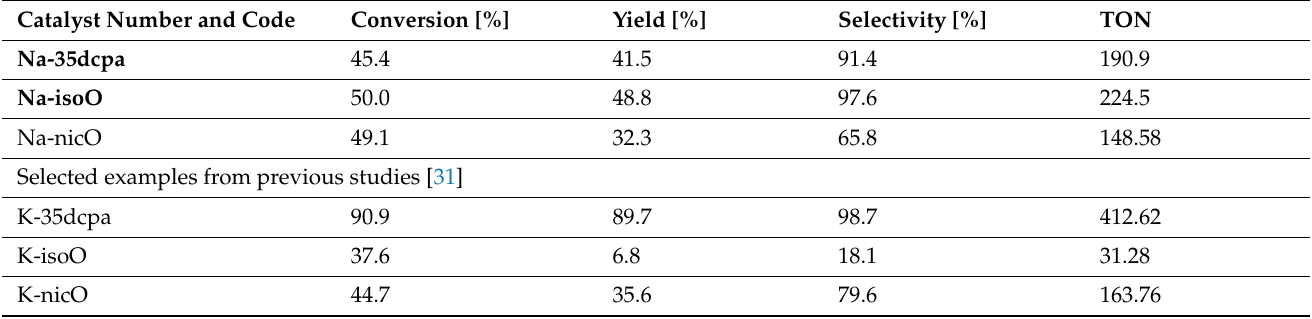
Table 5. The BV oxidation of cyclohexanone using molybdenum